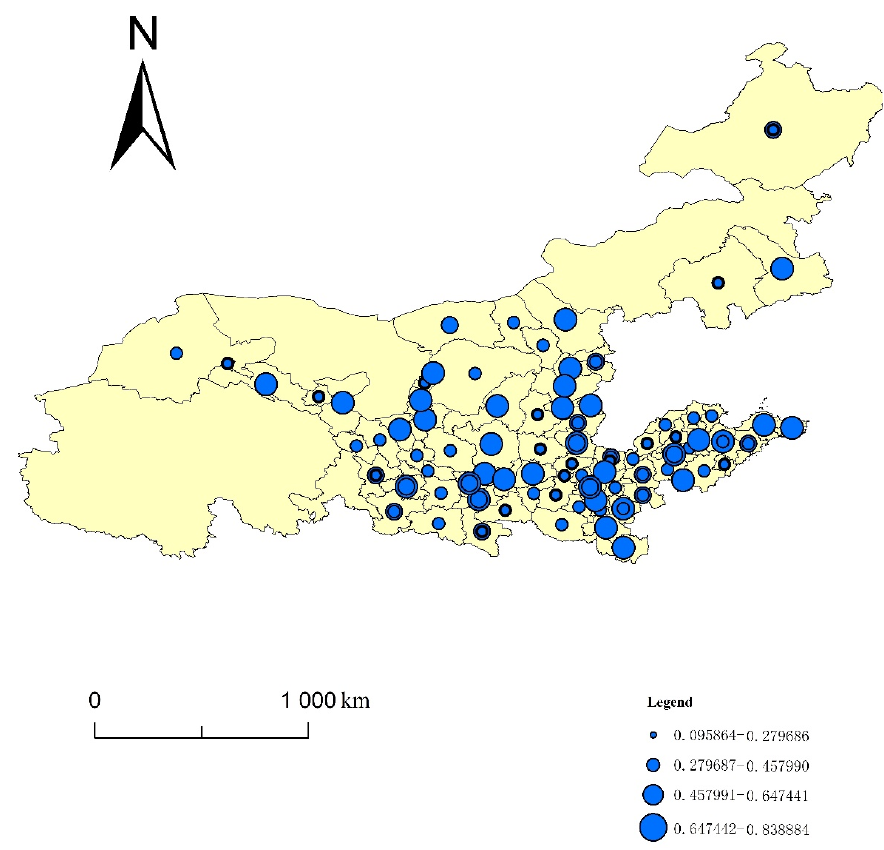
Figure 4. Spatiotemporal evolution of the UECC in the YRB.